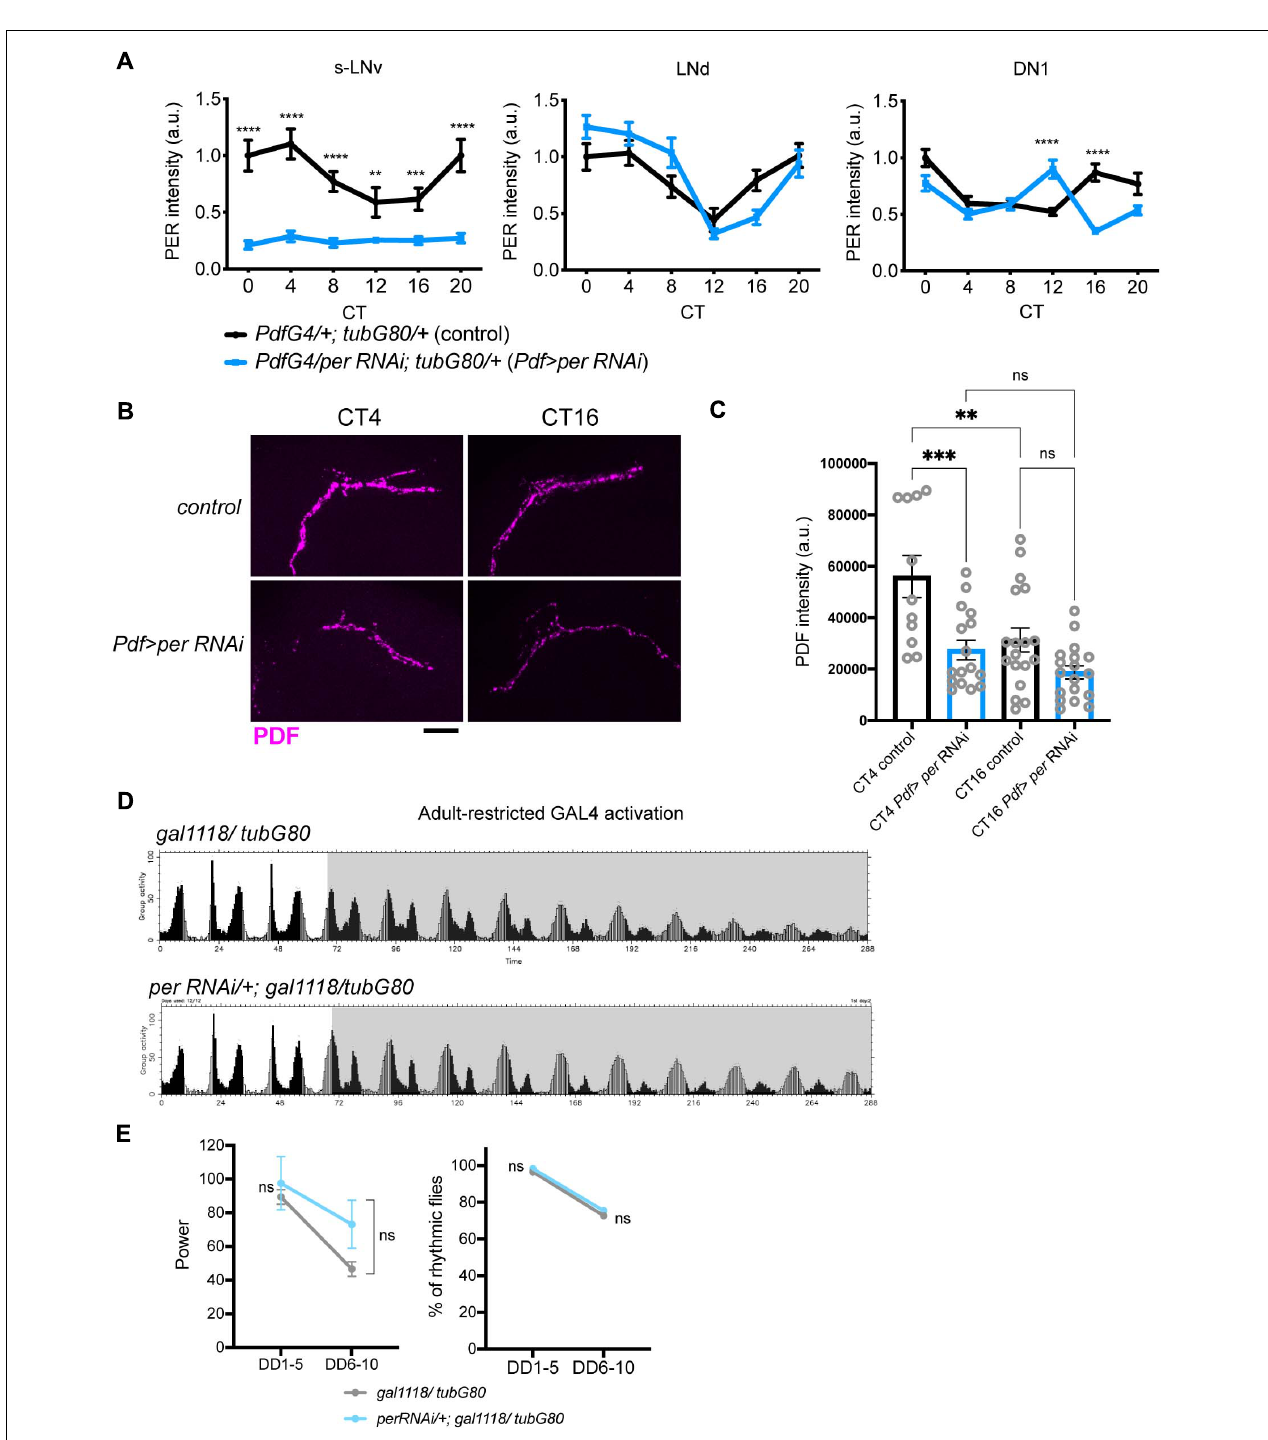
FIGURE 3 | PER knockdown in adult M-oscillators disrupts molecular clocks but has little effects on free-running locomotor rhythms. (A) UAS- per RNAi was expressed during adulthood with a combination of Pdf-GAL4 , tub-GAL80 ts . PER levels were quantified on DD3 in the s-LNvs, DN1s and LNds. n = 14–19 per group. ** p < 0.01, **** p < 0.0001 comparing two genotypes at each timepoint by multiple unpaired t -test with Welch’s correction. (B,C) PDF levels in the s-LNv dorsal terminals at two timepoints on DD3. Representative confocal images (B) and quantification (C) of indicated genotypes. Scale bar, 20 µ m. n = 11–18 hemispheres per group. ** p < 0.01, *** p < 0.001 by 2-way ANOVA with Sidak’s multiple comparison test. (D) Group average locomotor activities of the flies with adult-restricted expression of per RNAi driven with the combination of gal1118 and tub-GAL80 ts and the control group carrying only the driver in LD and DD. (E) Left, power of rhythmicity in DD1-5 and DD6-10 in the indicated genotypes. No significant differences were found between two groups by the unpaired t -test with Welch’s correction. Right, percentage of rhythmic flies in DD1-5 and DD6-10. No significant differences were found by Fisher’s exact test.